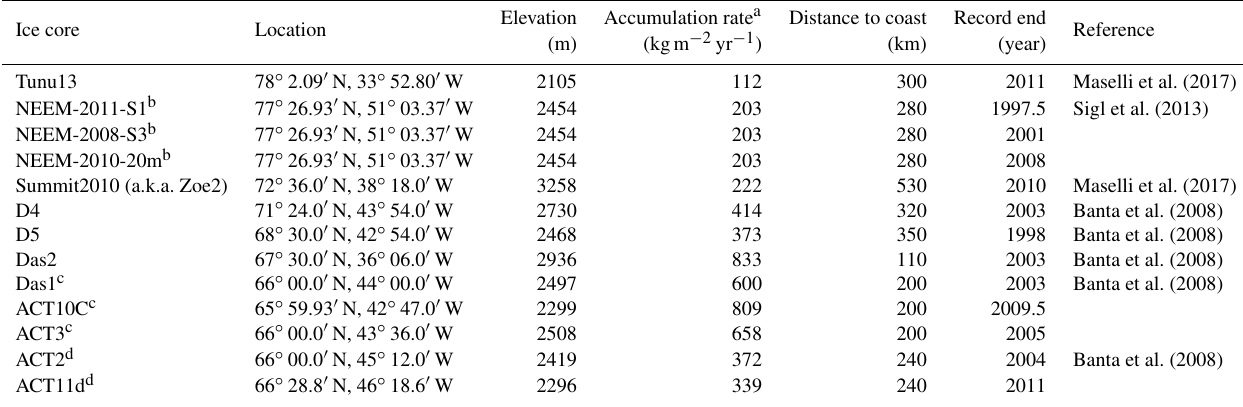
Table 2. Key characteristics of Greenland ice core records used. Ice core